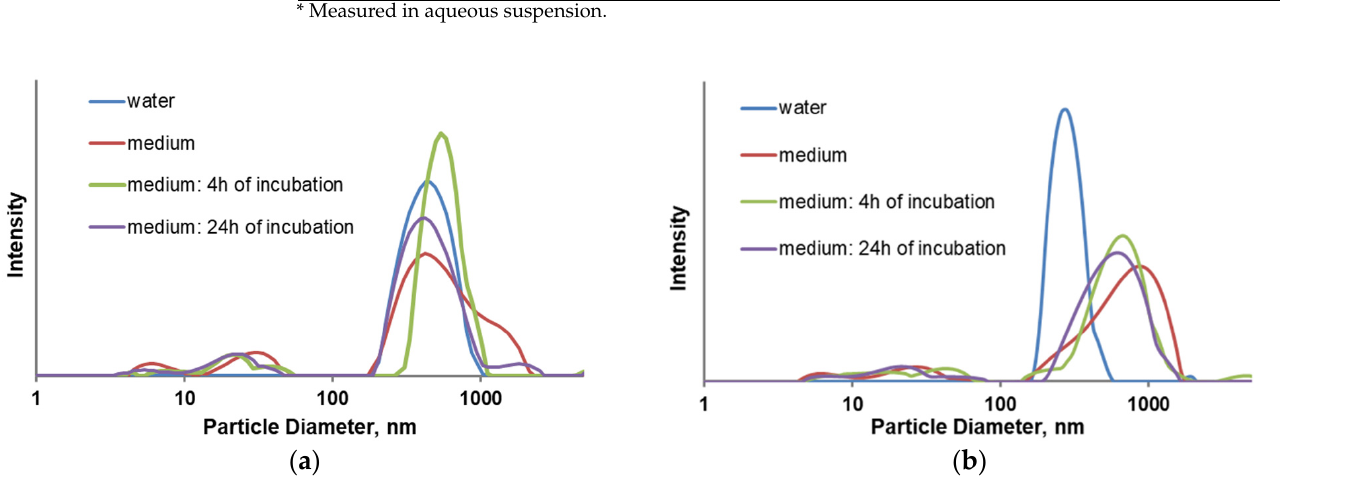
Particle size distribution of ( a ) MSN-H1[Ir] and ( b ) MSN-H2[Ir] in water and culture